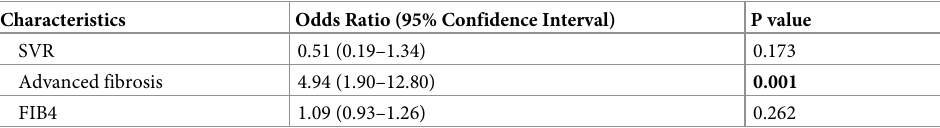
Table 2. Multiple logistic regression analysis for cryoglobulinemia persistence. Multivariate logistic regression model adjusted with SVR, fibrosis and